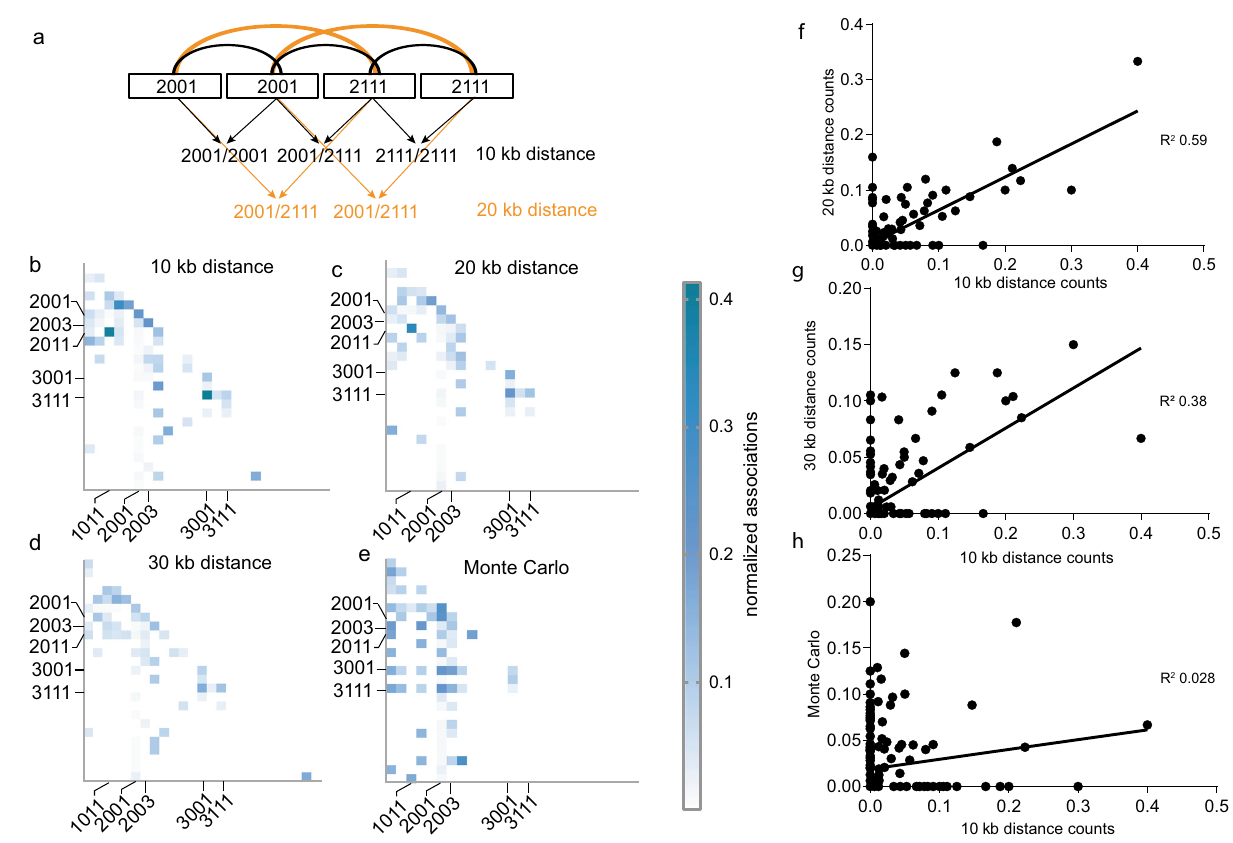
Fig. 2 NOR2 is organized in distinct rDNA clusters. a Graphical description of the NeighbourFinder program. It counts the occurrence of rDNA unit types at a 10 kb (immediate neighbor), 20 kb (one unit downstream), or 30 kb (neighbor two units downstream) distance. b – e Heat maps depicting the number of neighboring rDNA unit types at a 10, 20, or 30 kb distance normalized to the sum of the rDNA units bearing the given features. Dark blue colors depict the highest relative number (0.42) and white the lowest (0). rDNA variants are listed as follows for each heat map: on the y -axis from top to bottom and for the x -axis from the left to right: 1001, 1003, 1011, 1013, 1111, 2001, 2003, 2011, 2013, 2101, 2111, 2113, 3001, 3011, 3111, 4001, 4111, 5001, 1003D, 1011D, 1013D, 2001A, 2001C, 2001B, and 2003C, (A, B, C, and D depict large deletions, see Table 1 for glossary) Most abundant ones are indicated. f – h Scatter plots showing the correlation between the frequencies of associated rDNA units of the 10 kb distance with the 20 kb distance ( R 2 = 0.59) ( f ), 10 kb distance with 30 kb distance ( R 2 = 0.38) ( g ), and the 10 kb distance with the numbers obtained by the Monte Carlo simulation ( R 2 = 0.028) ( h